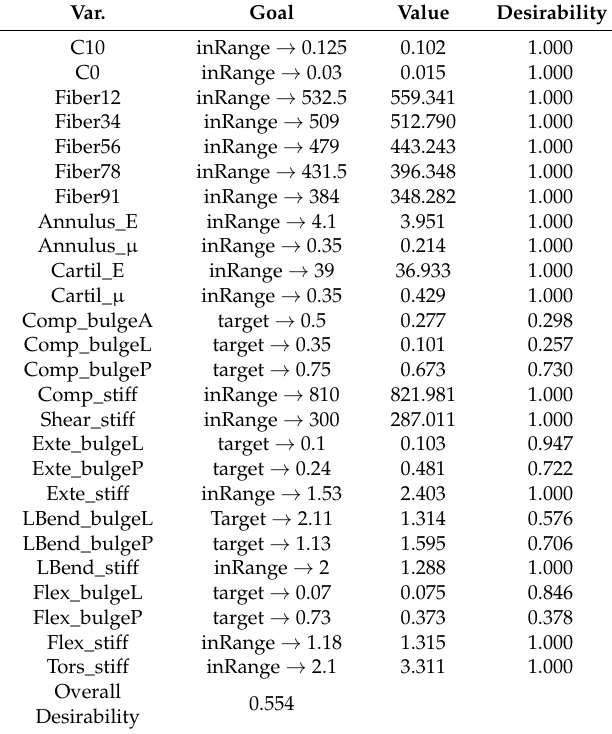
Table 30. The third criterion considered: setting the target of the FE model parameters based only on the